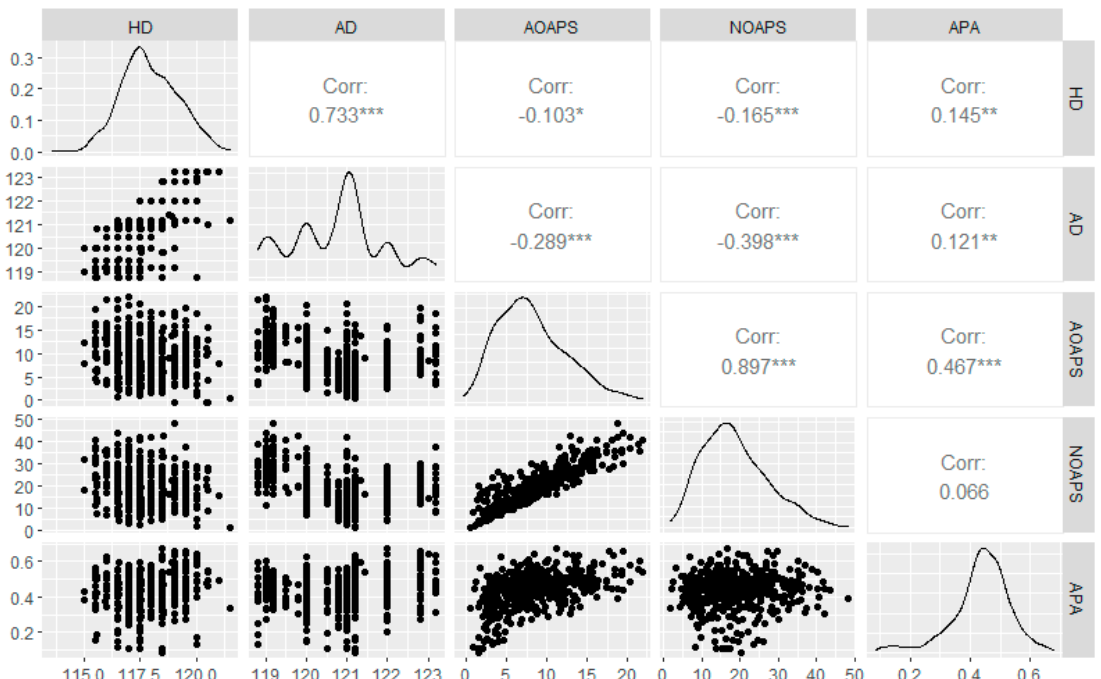
Figure 2. A pairs plot of the BLUES derived from the linear models. The lower triangle displays the scatterplots of each comparison with the population mean labeled with a red dot. The diagonal displays the histogram of the labeled trait with an overlayed density curve. The upper triangle displays the Pearson’s correlation coefficient. Any coefficient without an asterisk is insignificant ( p > 0.05). Otherwise, asterisks denote the following: ∗ = p ≤ 0.05, ∗∗ = p ≤ 0.01, ∗ ∗ ∗ = p ≤ 0.001.